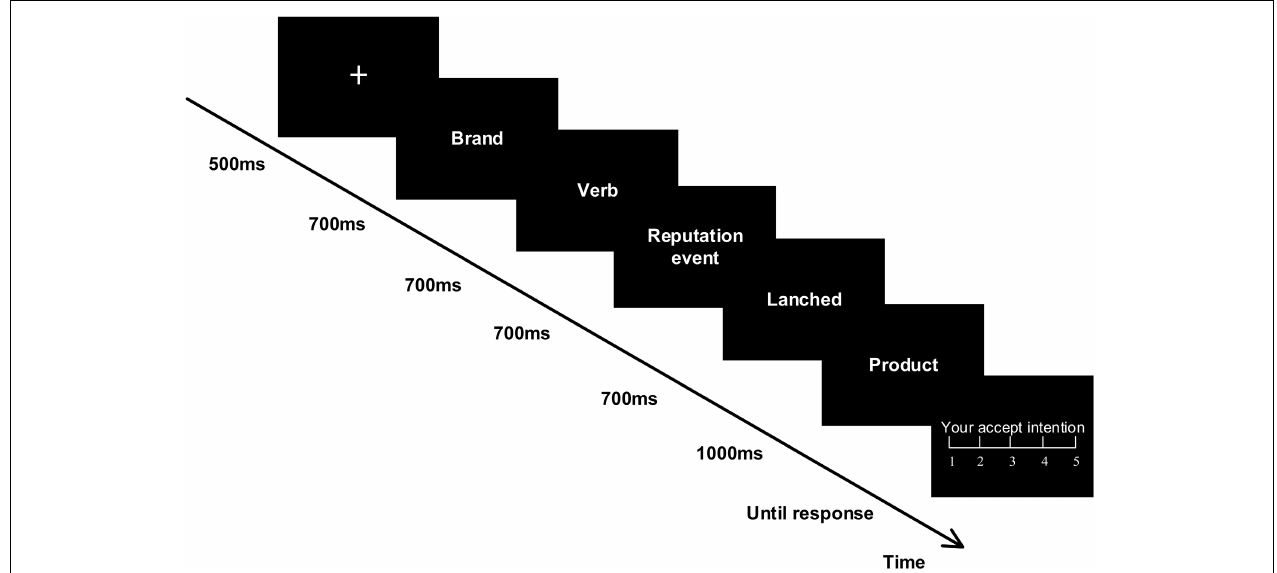
FIGURE 1 | Experimental task: Participants were presented with four conditions of stimuli sets, each formed into one sentence in Chinese. They were instructed to report their acceptance intentions toward the given extension products on a five-point scale.